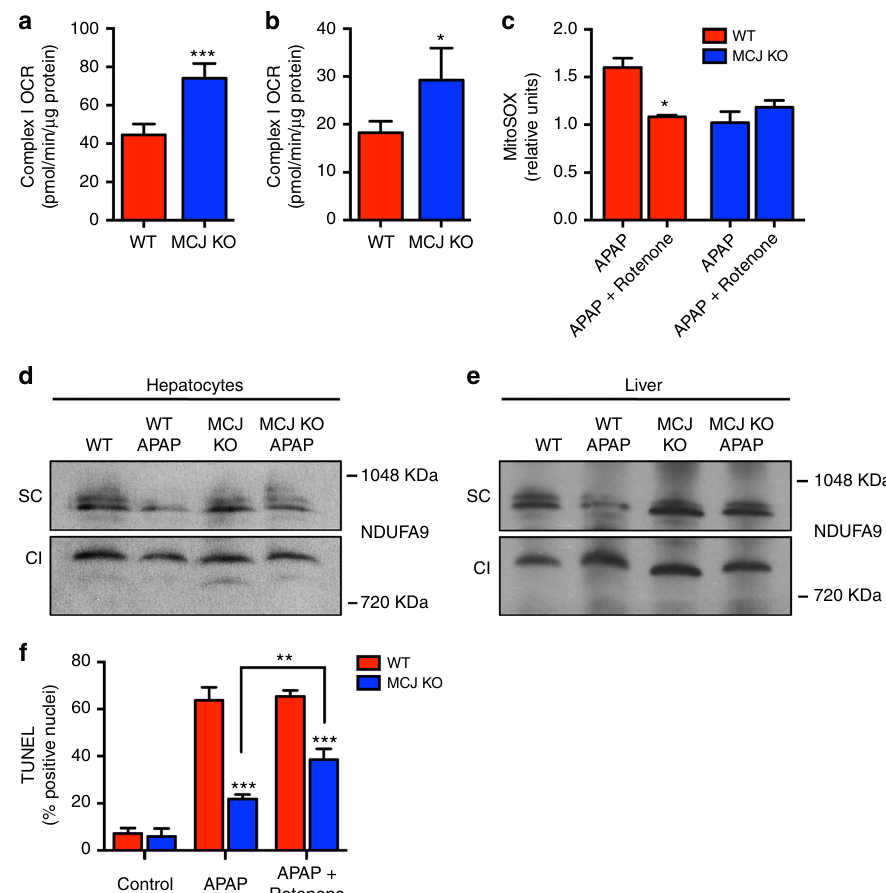
Fig. 5 Loss of MCJ prevents APAP-induced inhibition of respiratory supercomplexes and ROS generation in liver. a Complex I OCR in WT and MCJ KO liver mitochondria at basal conditions ( n = 3). b Complex I OCR in WT and MCJ KO liver mitochondria after APAP treatment ( n = 3). c Mitochondrial ROS in WT and MCJ KO hepatocytes treated with APAP (6 h) and Rotenone (complex I inhibitor) (3 h) using MitoSOX dye. BN-PAGE of digitonin-solubilized mitochondrial extracts from WT and MCJ KO hepatocytes d , e livers treated with APAP transferred into a membrane and immunoblotted for NDUFA9 protein. Immunoreactivity within the supercomplex (SC) region and the monomeric complex I (CI) is shown. f Cell death was evaluated using TUNEL in WT and MCJ KO hepatocytes treated with APAP (9 h) and Rotenone (3 h). Values are represented as mean ± SEM. * P < 0.05, ** P < 0.01, *** P < 0.001 (Student ’ s t test) (MCJ KO vs. WT and APAP + Rotenone vs. APAP). Triplicates were used for experimental condition